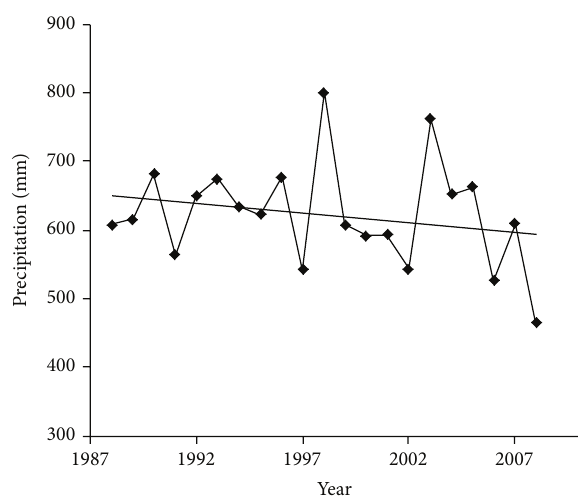
Figure 5: Trend of the variation of annual precipitation.